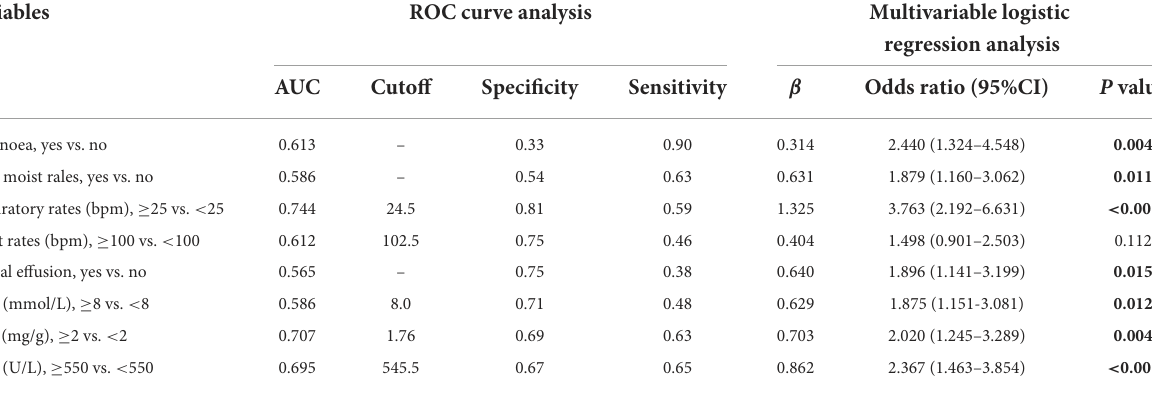
TABLE 5 ROC analysis and multivariable logistic regression analysis of the selected risk factors of ICU admission of patients with PCP identified by LASSO regression. Variables ROC curve analysis Multivariable logistic regression analysis AUC Cutoff Specificity Sensitivity β Odds ratio (95%CI) P value